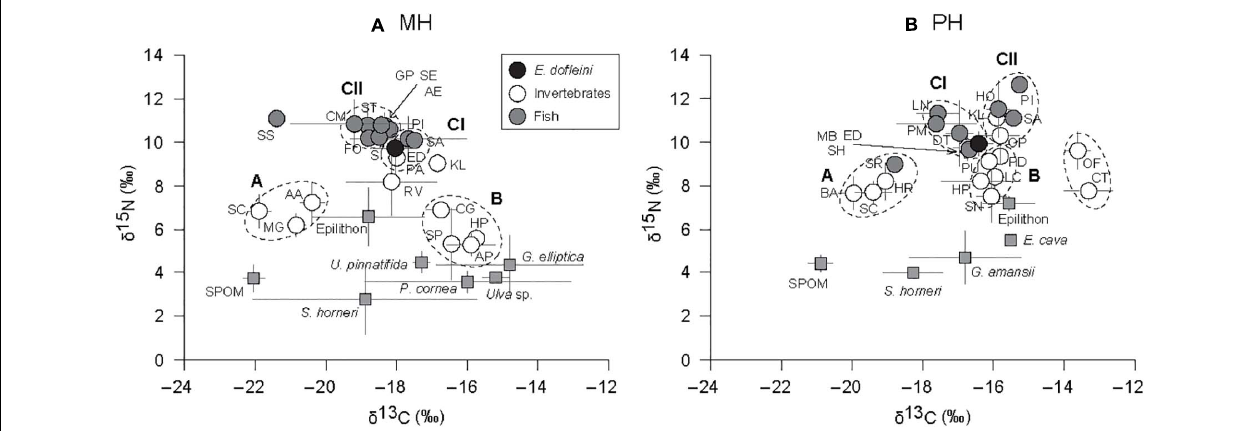
FIGURE 5 | Bi-plots of δ 13 C and δ 15 N values of primary sources of organic matter and consumers at the MH (A) and PH (B) sites. Species codes are given by acronyms of first letters of genus and species name, and listed in Tables 3 , 4 . The groups of taxa (dotted circles) were chosen from the hierarchical cluster analysis. Full gray squares denote primary sources of organic matter. Circles represent fish (gray), Enteroctopus dofleini (dark), and macroinvertebrates (white).